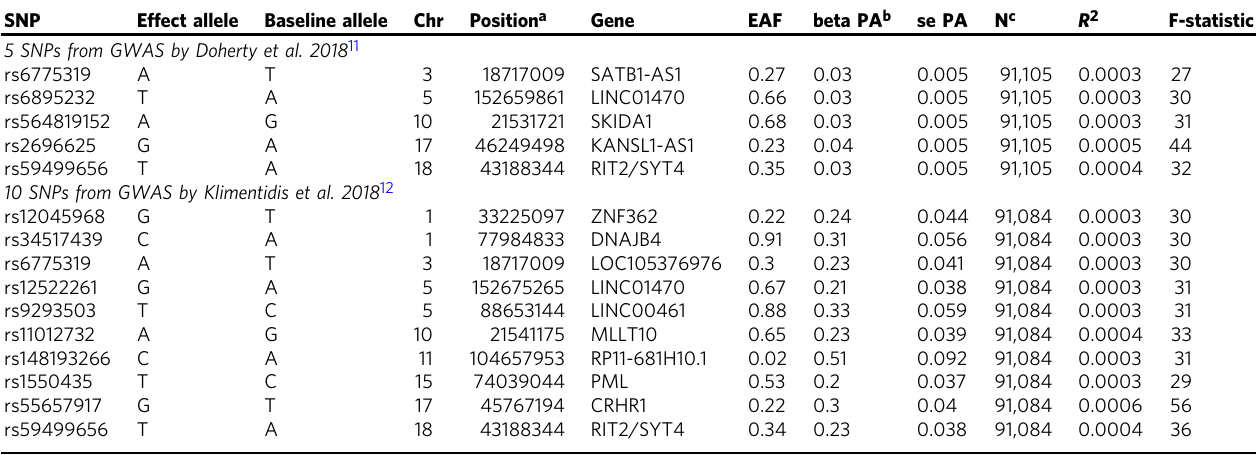
Table 2 Summary information on accelerometer-measured physical activity SNPs used as genetic instruments used for the Mendelian randomisation